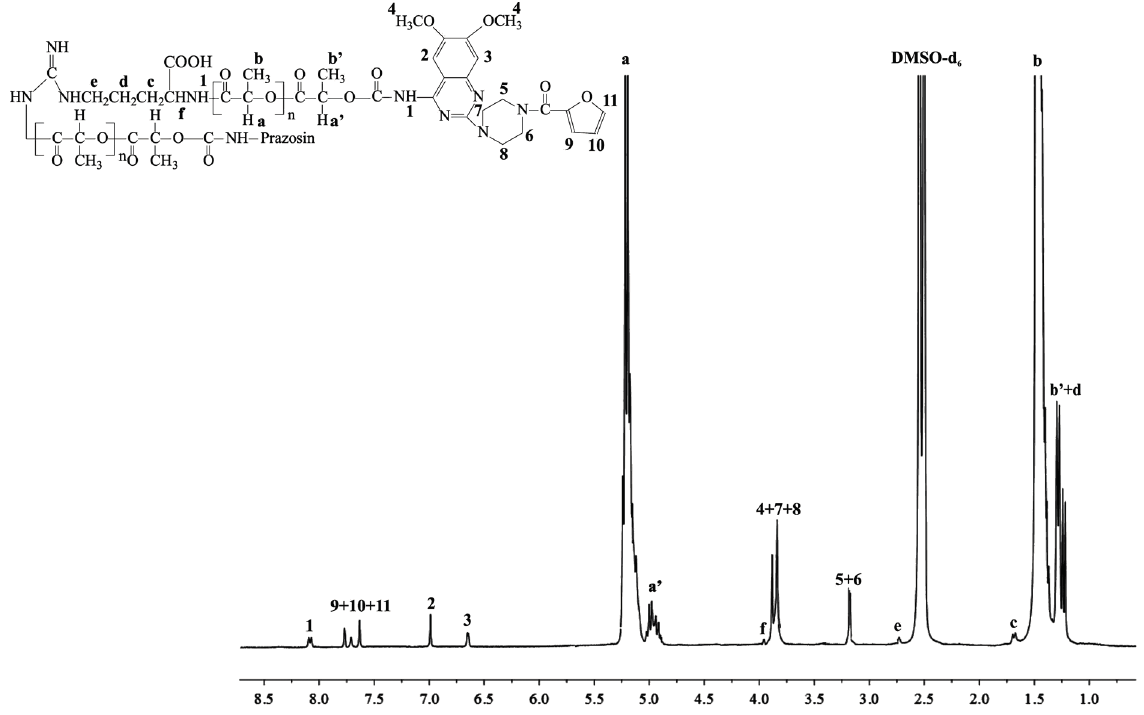
Figure 2. 1 H-NMR spectrum of the prazosin–PLLA/Arg